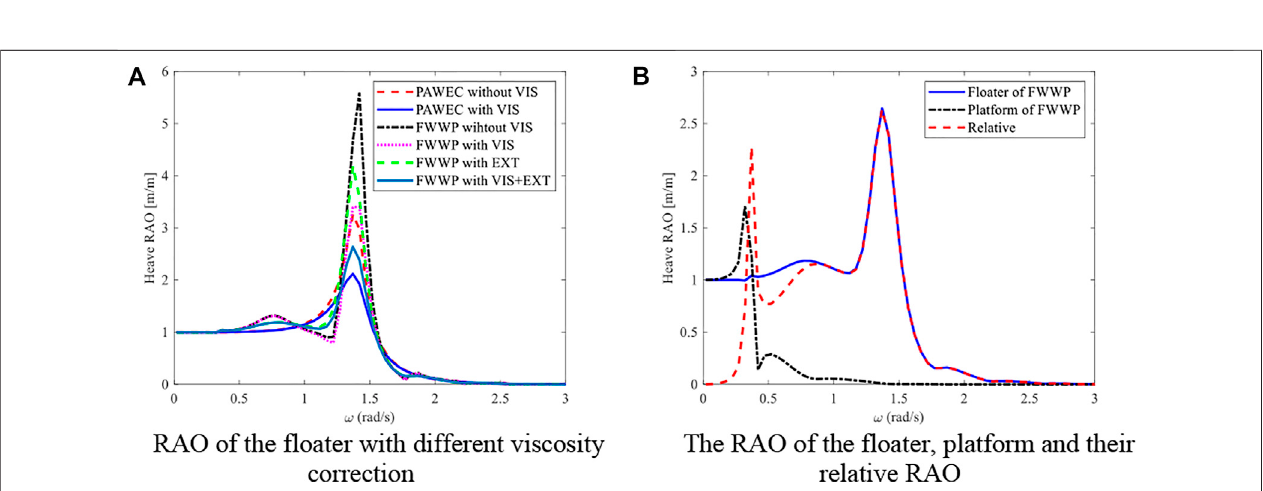
FIGURE 9 | Heave RAO with hydrodynamic correction. (A) RAO of the fl oater with different viscosity corrections. (B) The RAO of the fl oater and platform and their relative RAO.